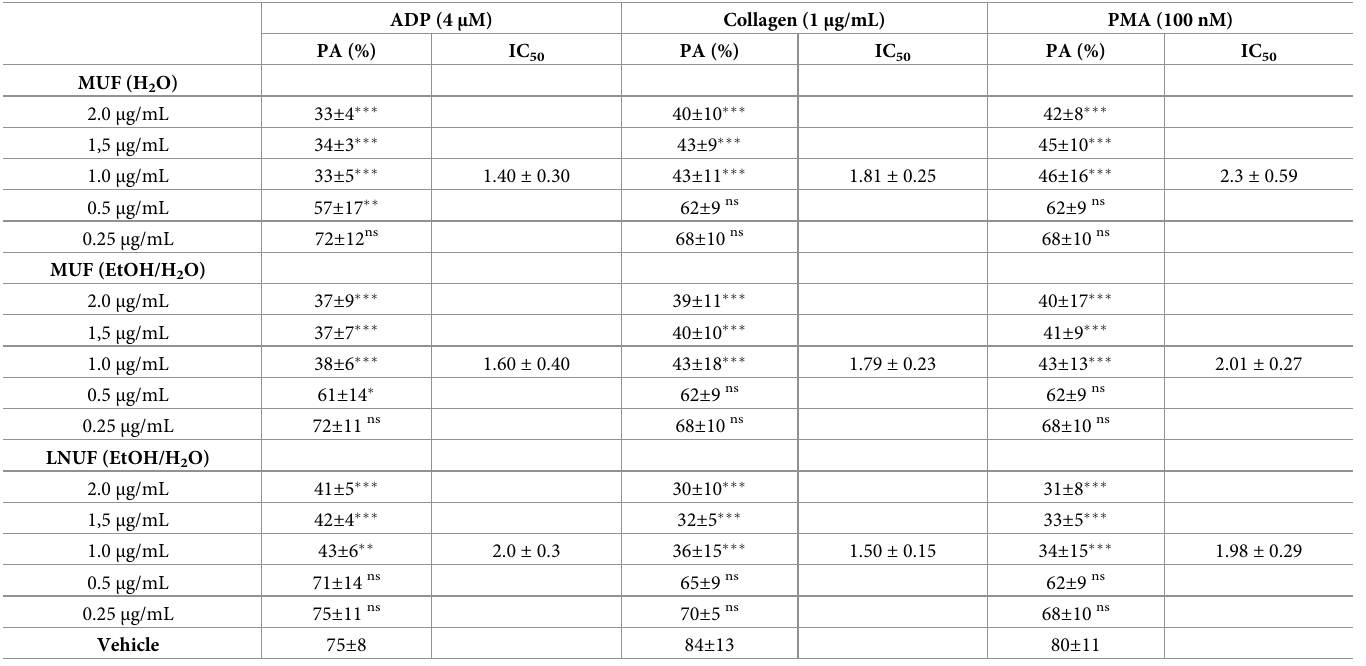
Table 2. Inhibitory effect of the most active extracts of A . chilensis on platelet aggregation stimulated by collagen and TRAP-6.